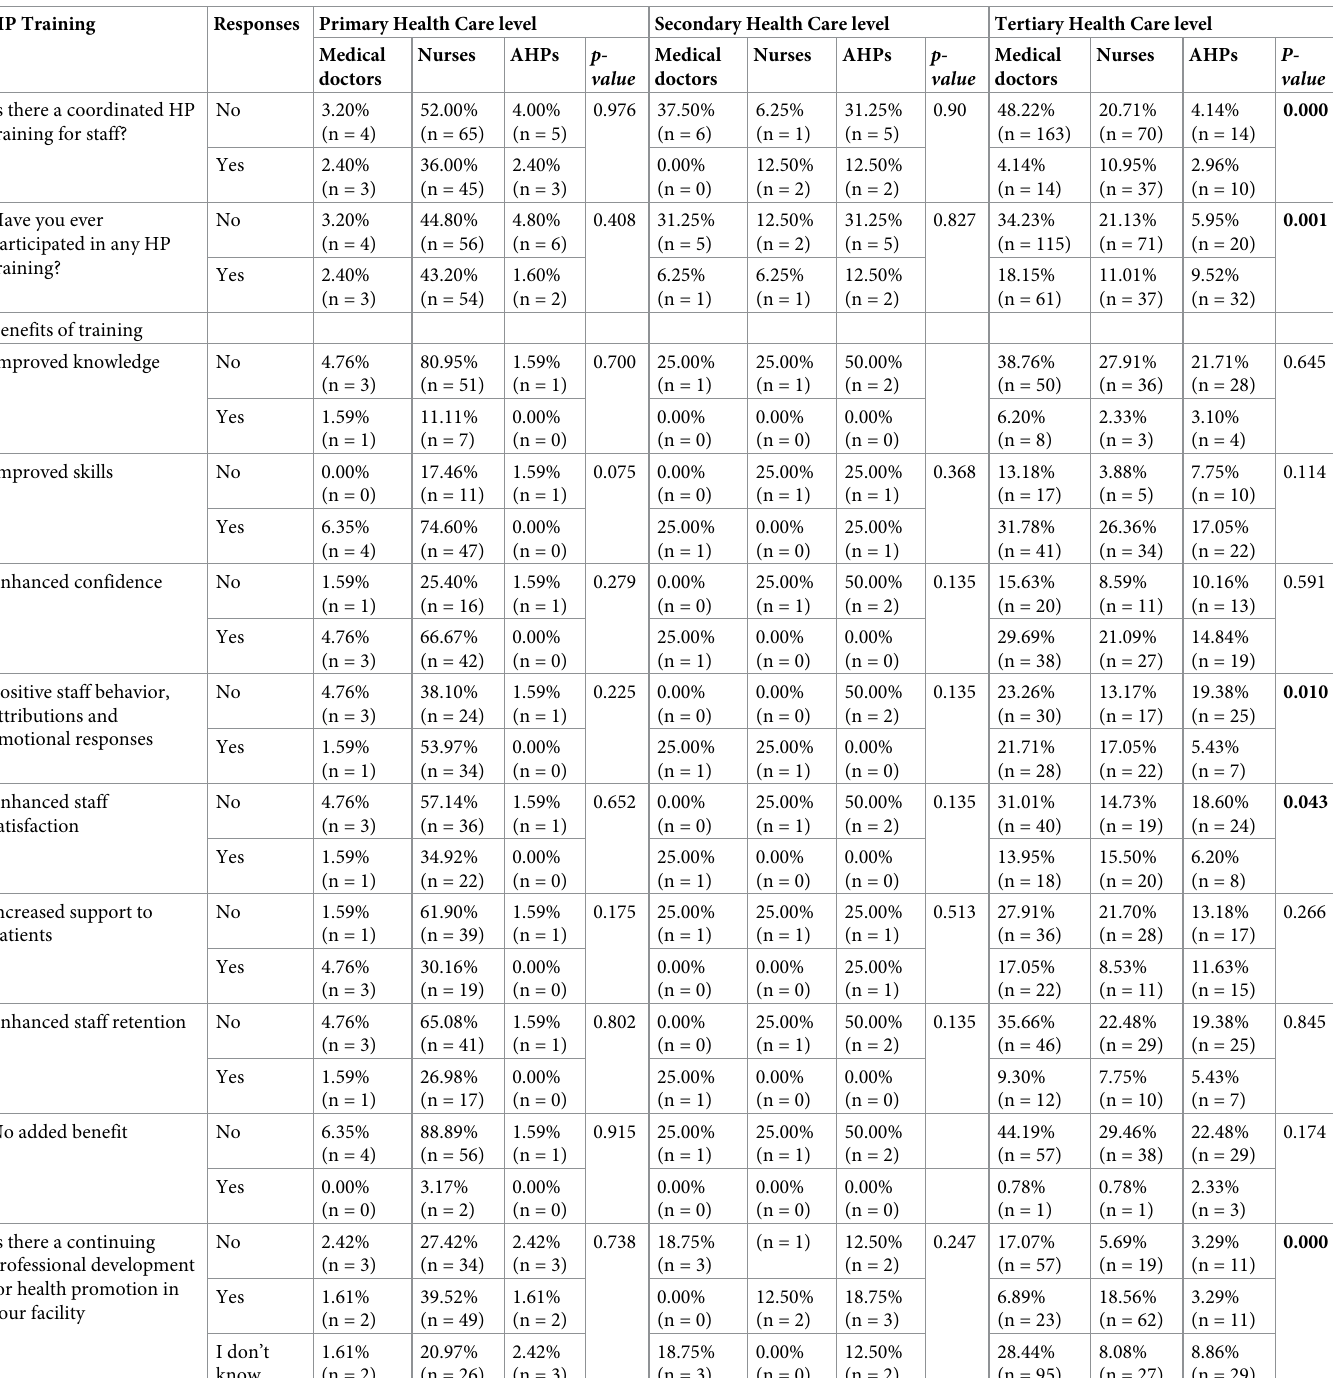
Table 2. Bivariate analysis of HP and DP training and attitude of HCPs at different levels of healthcare. HP